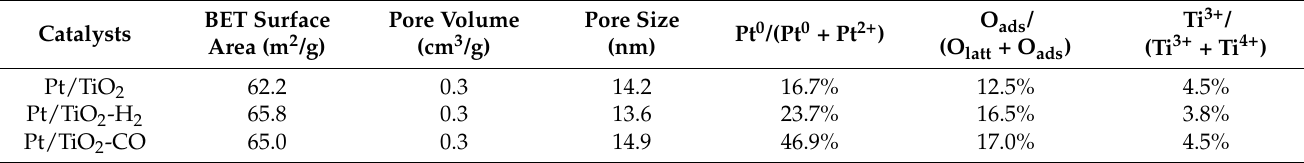
Table 1. Surface species concentrations (based on XPS peak area) and porous properties of Pt/TiO 2 , Pt/TiO 2 -H 2 , and Pt/TiO 2 -CO catalysts.